Question: Write a descriptive caption for this figure.
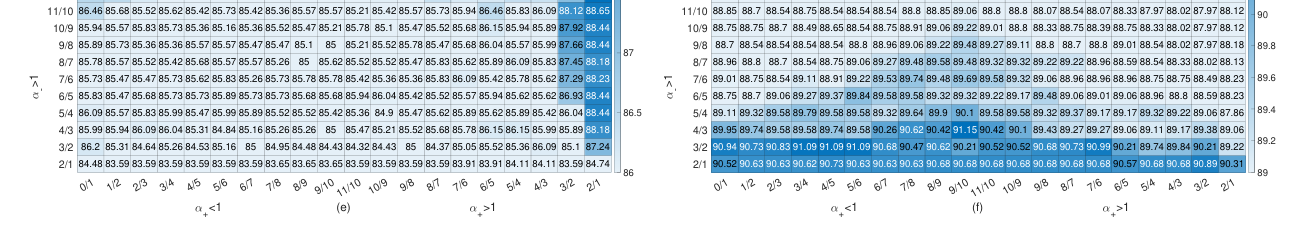
Answer: Matrix patterns of the 20 × 20 SIC models of the test classification accuracy of (a) statlog-australian- credit, (b) horse-colic, (c) ecoli, (d) arrhythmia, (e) energy-y1, and (f) energy-y2. Here statlog-australian-credit and horse-colic are two-class datasets. And ecoli, arrhythmia, energy-y1, and energy-y2 are multi-class datasets. Both energy-y1 and energy-y2 have the same input dataset but look for hyperplanes for opposite outputs, i.e., y1 for the heating load, while y2 for the cooling load [51]. The best performing (α+, α−) for energy-y1 and energy-y2 exhibit opposite patterns: (α+, α−) ≈(2, −) for energy-y1, and (α+, α−) ≈(−, 2) for energy-y2. Overall, the best-performing region of multi-class datasets is more localized than that of two-class datasets.